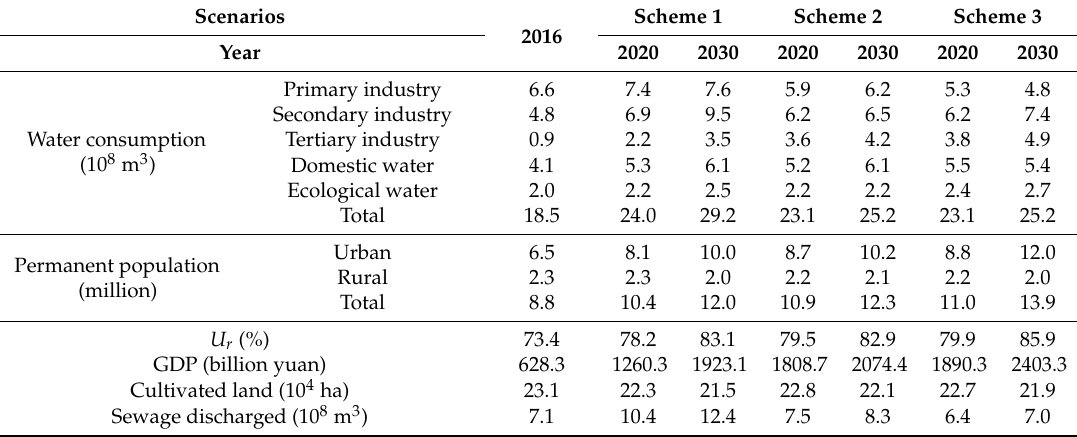
Table 3. The optimal thresholds of the urbanization scale of Xi’an in Schemes 1–3.